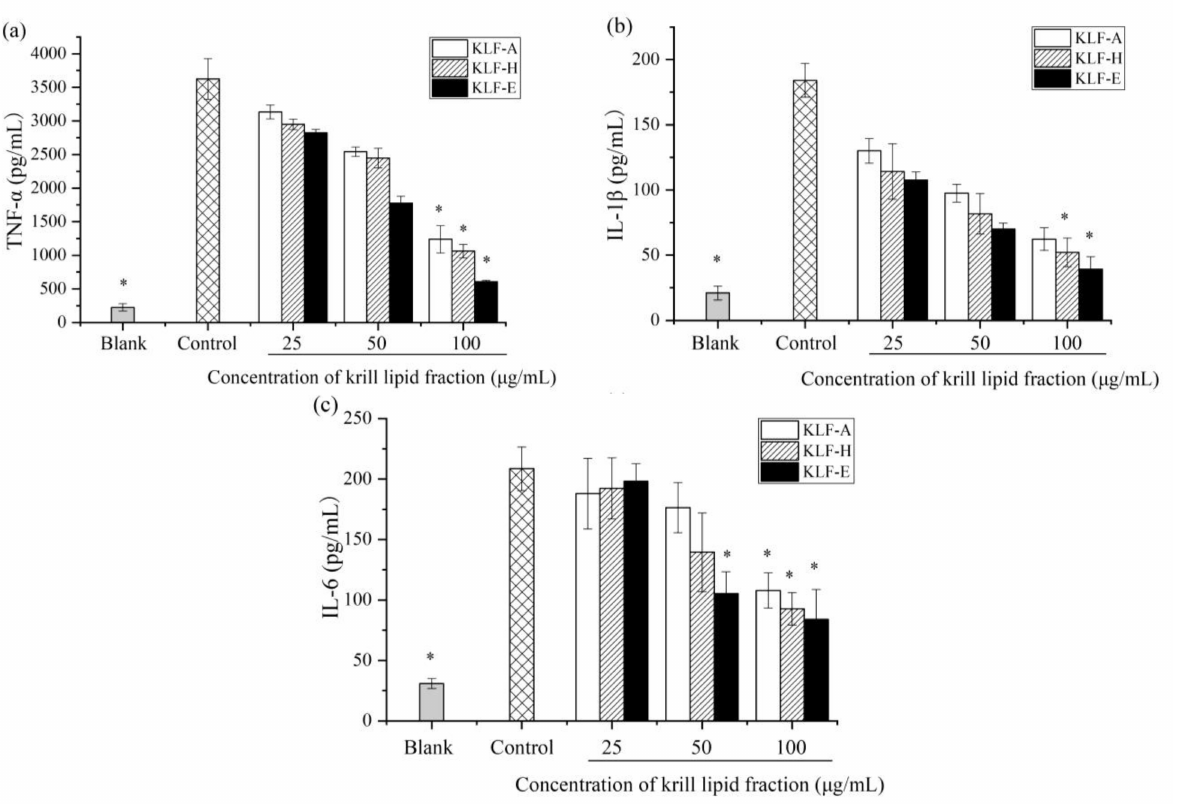
Figure 3. Effect of three krill lipid fractions on cytokine release in RAW264.7 cells with LPS stimulation: ( a ) TNF- α , ( b ) IL-1 β and ( c ) IL-6. Blank group referred to the untreated cells; cells treated with LPS alone were considered as the control group. * p < 0.05 versus the control group; the one-way analysis of variance (ANOVA) combined with Games–Howell test was used to analyze the significance. Abbreviations: LPS, lipopolysaccharide; KLF-A, the krill lipid fraction extracted with acetone in the first step; KLF-H, the krill lipid fraction extracted with hexane in the second step; KLF-E, the krill lipid fraction extracted with ethanol in the third